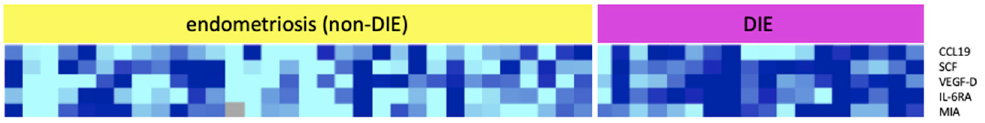
Figure 2. Heat map representing the target proteins that showed a significant difference in expression between endometriosis patients without deep-infiltrating endometriosis and patients with deep-infiltrating endometriosis. The color intensity corresponds to the expression level of the protein. Five biomarkers were significantly overexpressed in patients with DIE compared to endometriosis patients without DIE. In detail, Interleukin 6 receptor alpha (IL-6RA) was overexpressed 1.4-fold ( p = 0.004), Stem cell factor (SCF) 1.33-fold ( p = 0.033), Vascular endothelial growth factor D (VEGF-D) 1.75-fold, Chemokine ligand 19 (CCL 19) 1.9-fold ( p = 0.038), and